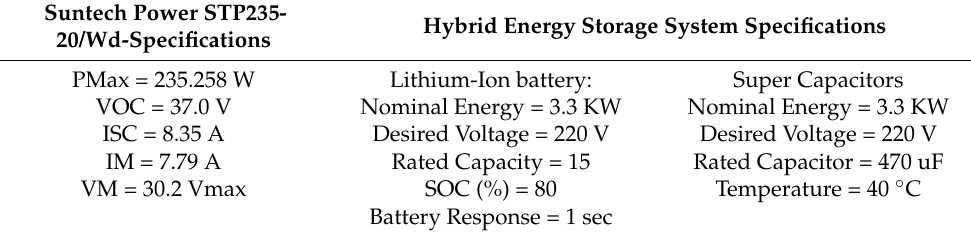
Table 4. PV Module and HESS